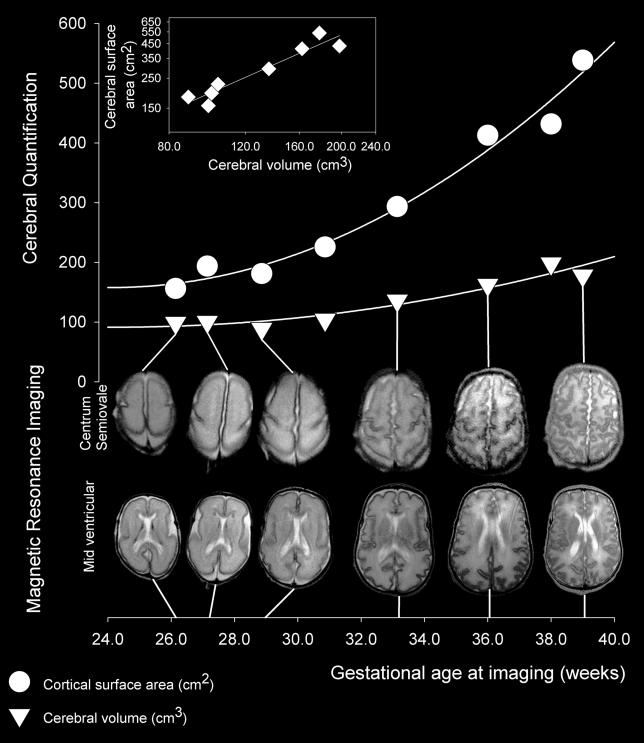
Serial MR Imaging of Brain Growth in a Normal Female Preterm InfantWhen this infant was born at 25 weeks gestational age she weighed 710 g. The images show slices through the brain at the mid-ventricular level and at the level of the centrum semiovale from six of the eight MR images obtained between 26 and 39 wk gestational age; images obtained at 30 and 38 weeks are omitted for graphical clarity. Measured values for cerebral volume (triangles) and cortical surface area (circles) are related to relevant image pairs by straight lines. The insert displays a scatter plot in log-log coordinates of cortical surface area and cerebral volume (diamonds), showing a linear relationship that indicates power law scaling of cortical surface area relative to cerebral volume in this individual.